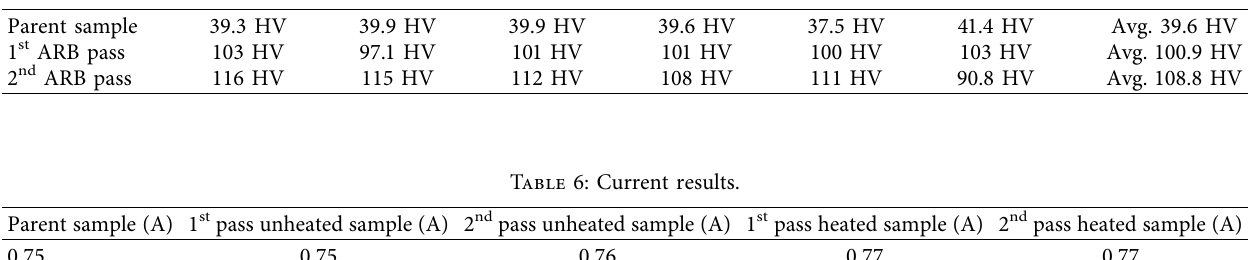
Table 5: Hardness test results of unheated material.